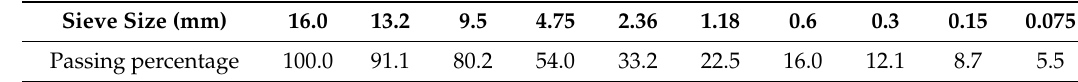
Table 2. Aggregate gradation.